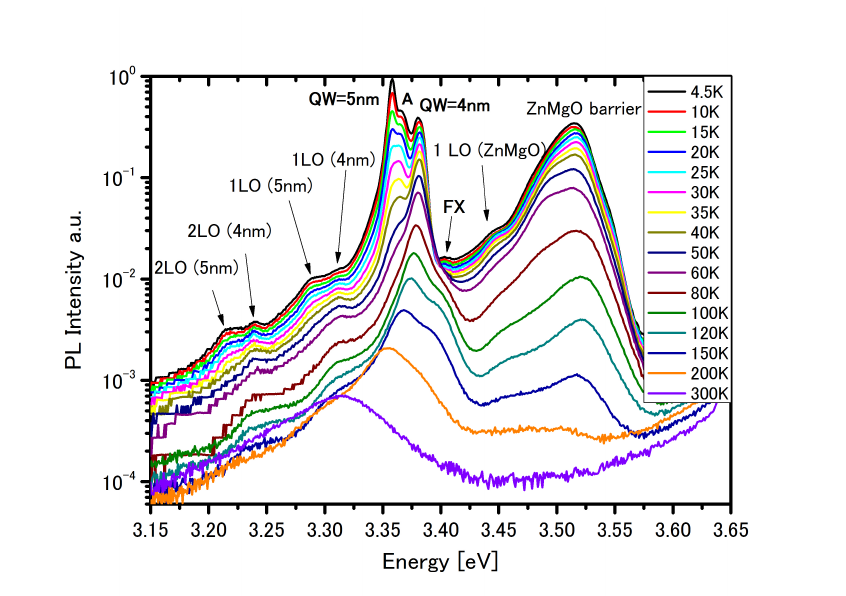
Figure 4. PL spectra at different temperatures for structure #2.